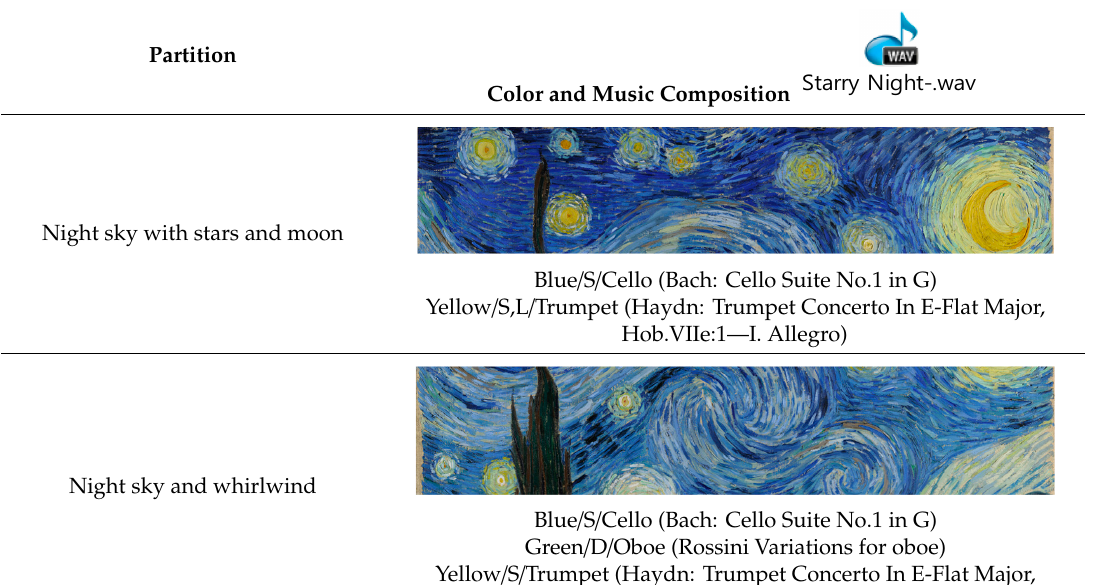
Table 6. Music composition with CLASSIC SCC for Vincent van Gogh’s The Starry Night,1889 ( Museum of Modern Art, New York).